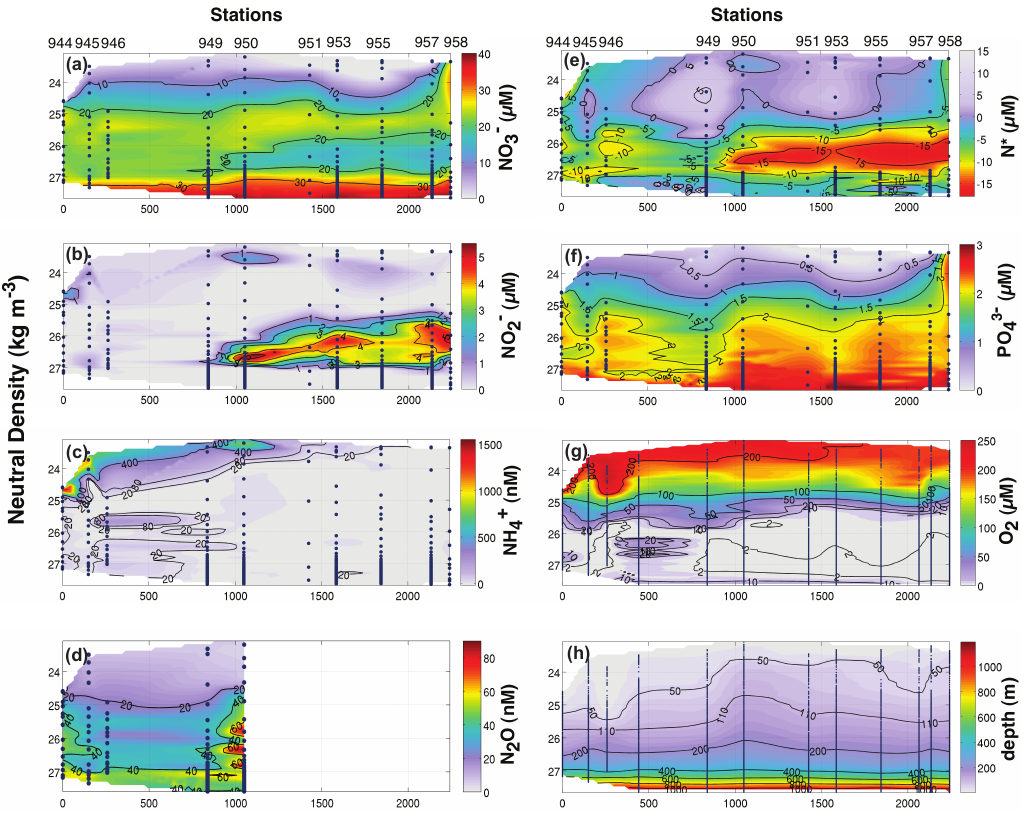
Fig. 2. Distribution of dissolved inorganic nitrogen, phosphate and oxygen throughout the oxygen minimum zone along the cruise track from the Omani Shelf leading to the central-northeastern Arabian Sea, plotted against neutral density: (a) nitrate, (b) nitrite, (c) ammonium, (d) nitrous oxide, (e) nitrogen deficits as N* (in µM = [Total inorganic nitrogen] − 16[PO 3 − dissolved oxygen and (h) the corresponding depths along the neutral density